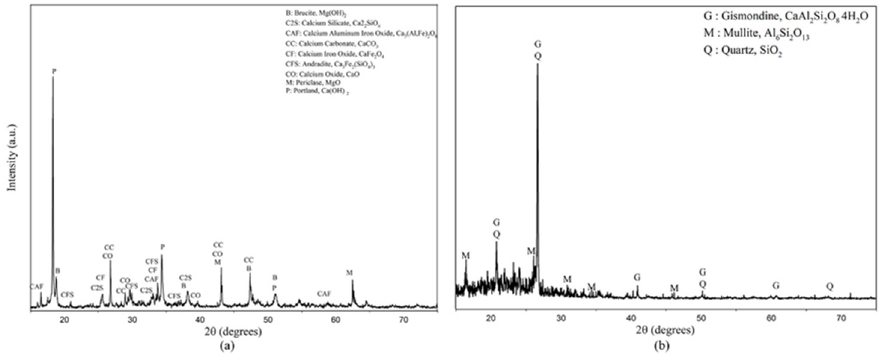
Figure 5. XRD pattern of ( a ) ladle slag and ( b ) fly